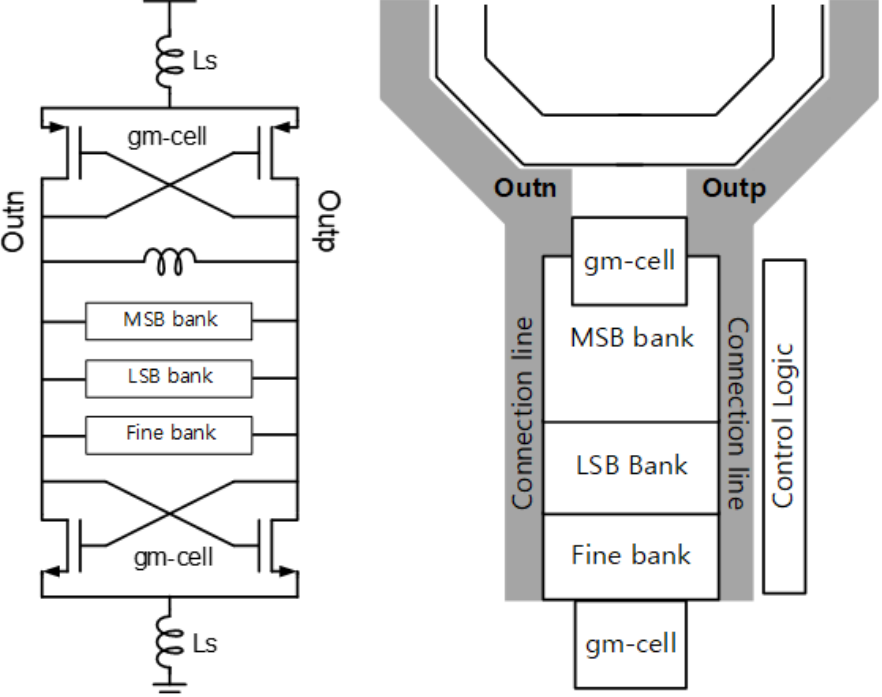
Figure 1. The general CMOS complementary digitally controlled oscillator (DCO) architecture and layout.